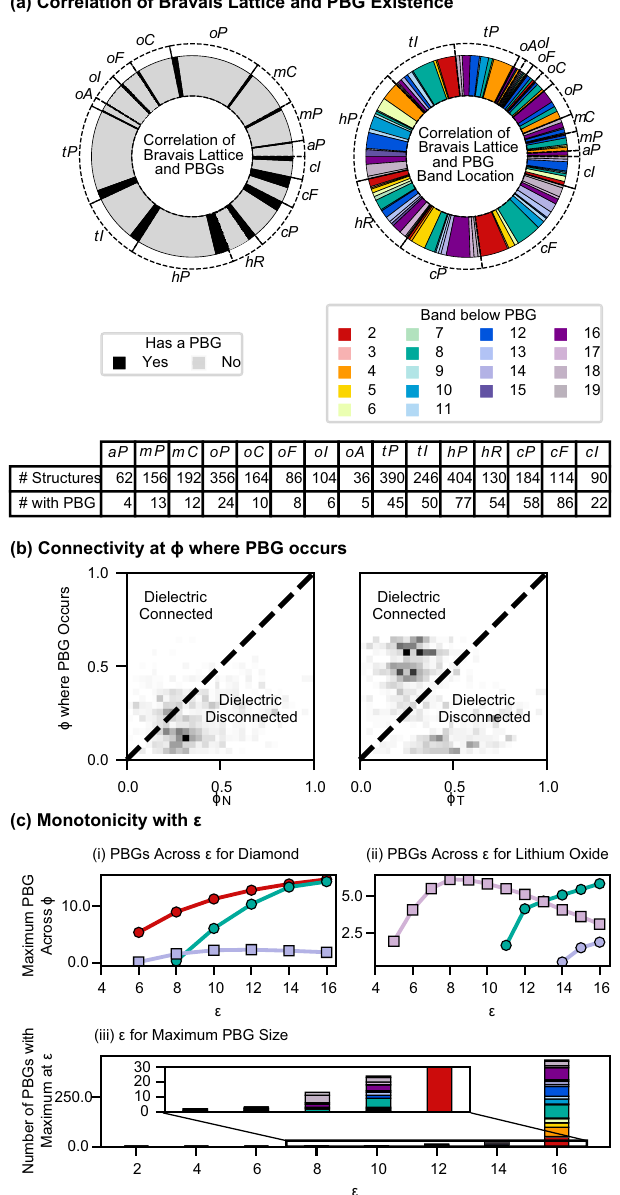
Fig. 2 Correlation of PBG existence, size, and location with structural features. a Bravais Lattice (BL) having a PBG or a PBG above speci fi c bands. A summary table for each BL is given. b Comparison of ϕ where PBGs occur with ϕ T and ϕ N . Data above and below the dotted lines denote PBGs that occur when the dielectric is connected or disconnected, respectively. c Monotonicity with ε . (i and ii) Size of PBGS in diamond (i) and lithium oxide (ii) across ε . PBGs that are non-monotonic with ε are denoted with squares. (iii) ε where the maximum PBG size occurs, which is an inset showing the PBGs with maxima at low ε